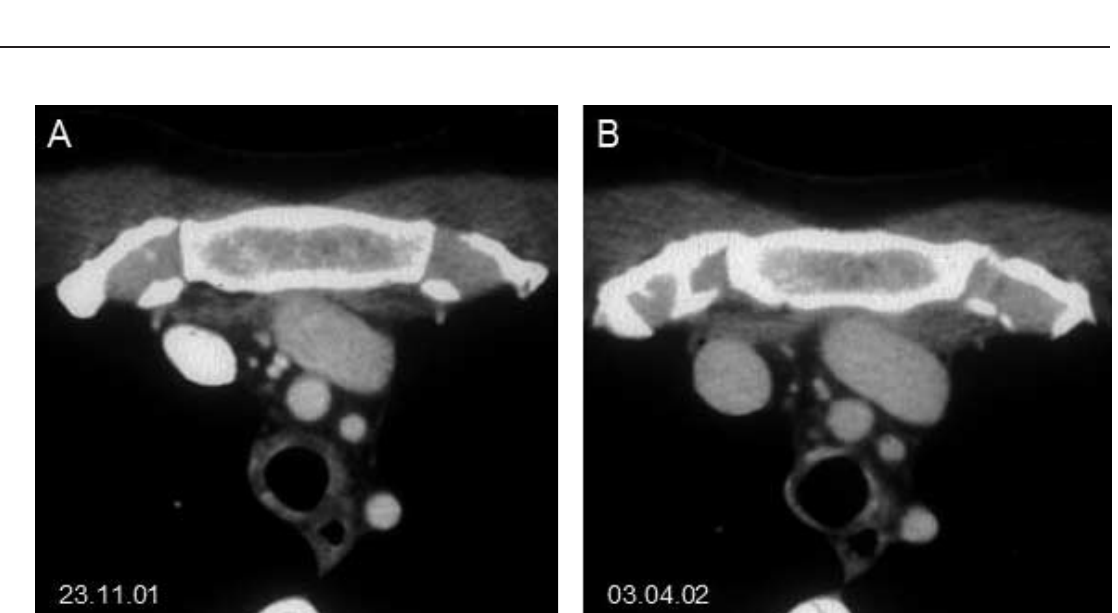
Wegener’s disease: A: In autumn 2001 the large airways of the right side oc- cluded with shrinking of the lung and trac- tion of the trachea to the right. As a conse- quence only the left diaphragm is visible on lateral exposure. B: Four weeks after infusion of infliximab (3 mg/kg body- weight) the right lung was re-ventilated. On lateral exposure both diaphragms are visi- ble. Addition of pred- nisone (50 mg per day) further im- proved ventilation (2C).